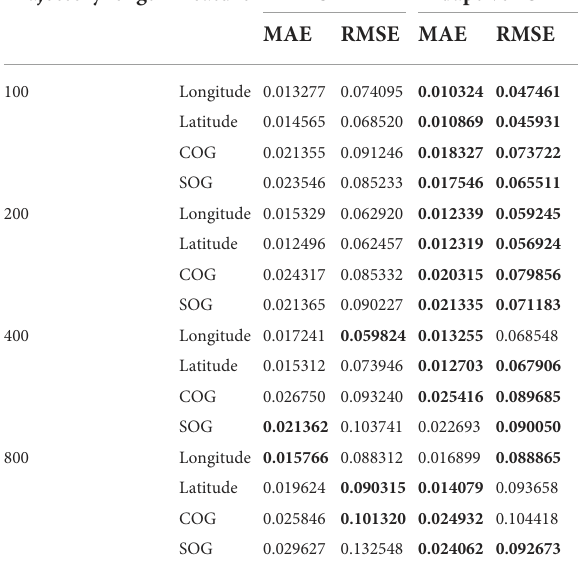
TABLE 2 Error comparison of different trajectory lengths and different models. Trajectory length